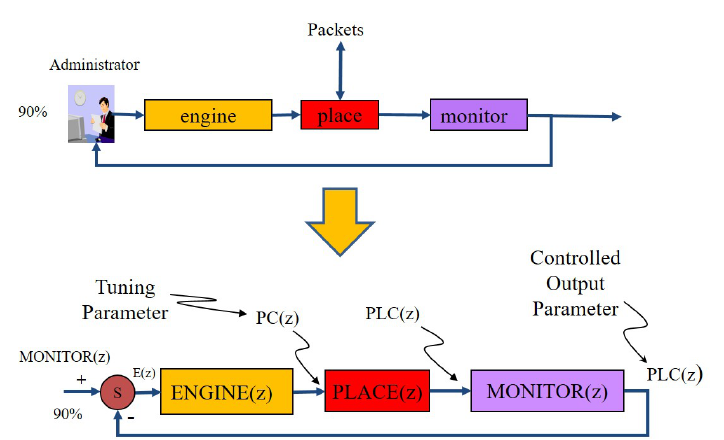
Figure 2. Feedback control for SDN